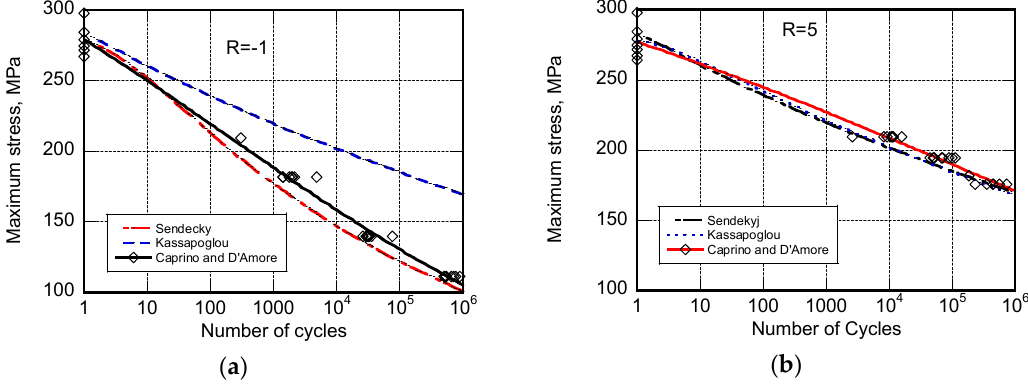
Figure 1. The experimental fatigue life data for AS4 / E7K8 PW—10 / 80 / 10, OH, at R = 0 ( a ) and R = − 0.2 ( b ) and the predictions of different models as indicated in the inset.